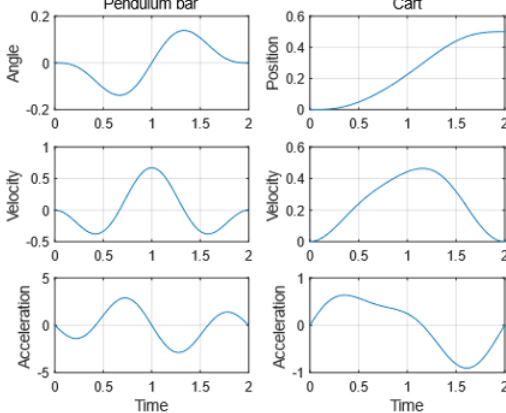
Fig. 2. Instance of desired trajectories.